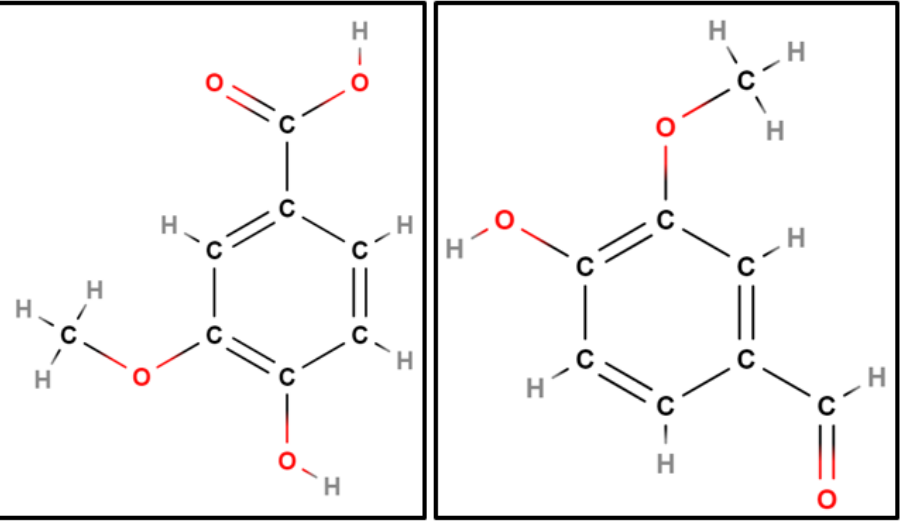
Figure 6. Structure of vanillic acid (C 8 H 8 O 4 ) (left) and vanillin (C 8 H 8 O 3 ) (right) . Vanillin can be extracted from lignin, ferulic acid, glucose, vanillic acid, aromatic